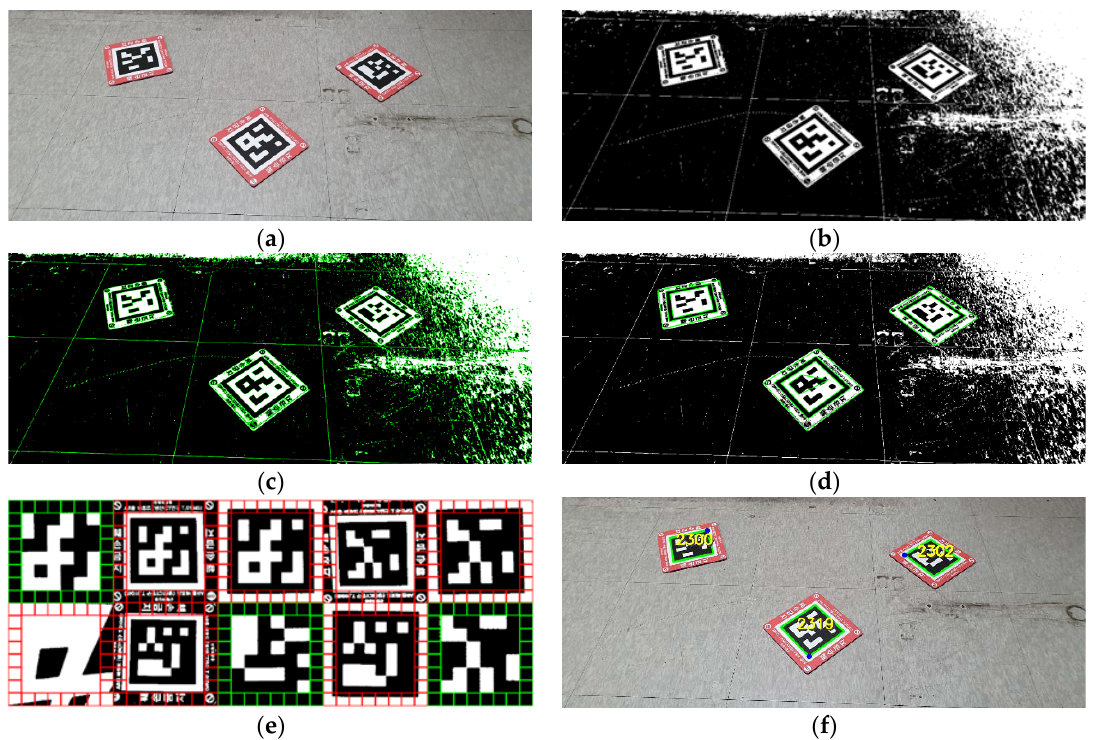
Figure 8. Overall process of marker detection. ( a ) original image; ( b ) image binarization; ( c ) contour extraction; ( d ) filtering with line approximation; ( e ) candidate voting; ( f ) detection results.